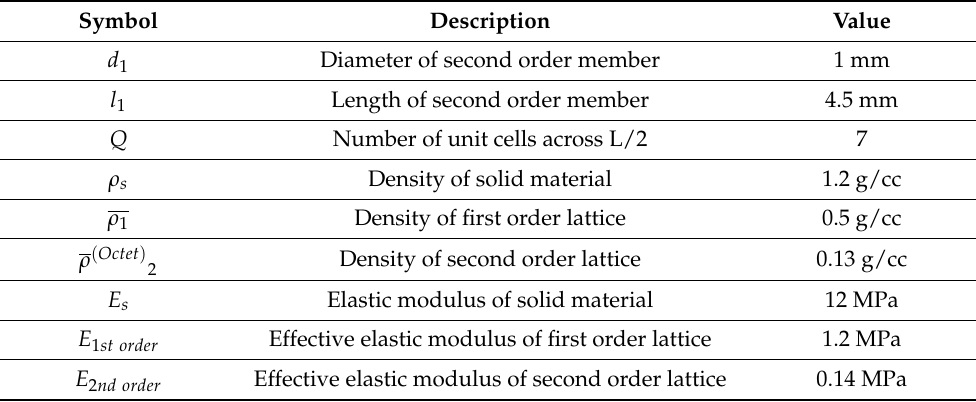
Table 5. Analytical parameters and results of the H1 and H2 octet. Symbol Description Value Diameter of second order